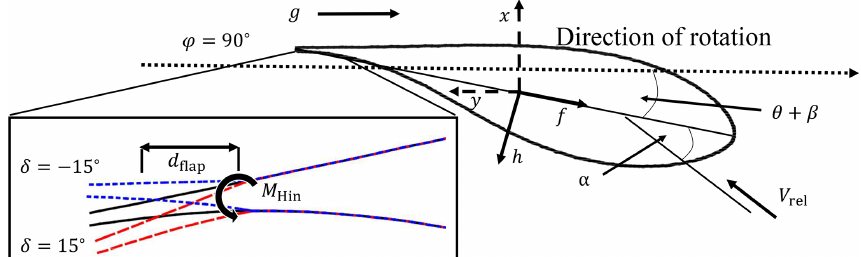
Figure 2. Sketch showing the angles and coordinate systems of a 2D airfoil section. The blade section is depicted at a rotor azimuth angle ϕ = 90 ◦ . The colors of the deflected flaps correspond to the polar data of Fig.